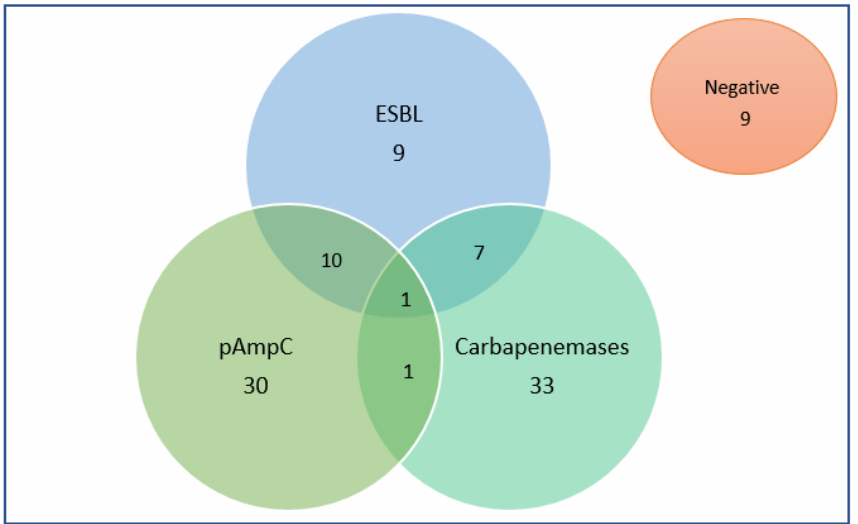
Figure 2. Phenotypic characterization of the strains by reference methods according to the ability to produce β -lactamases.